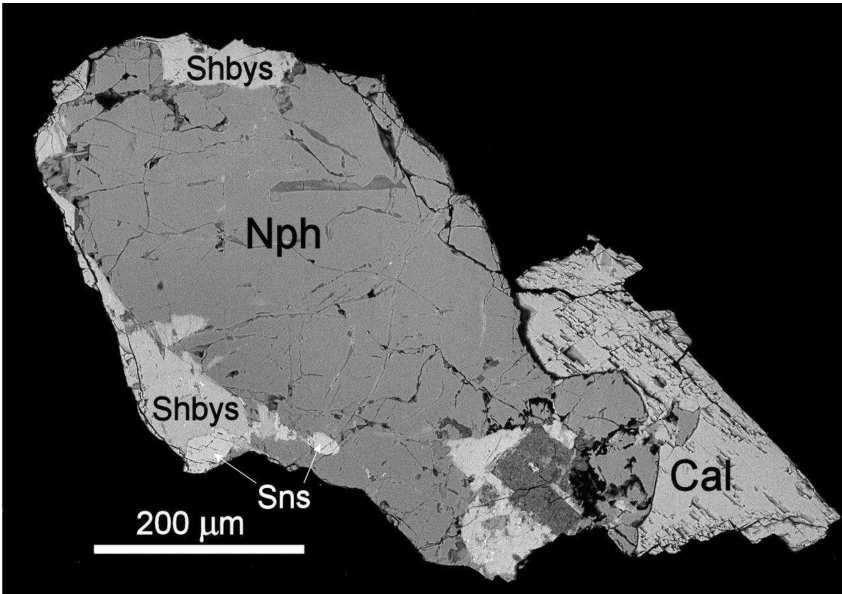
Figure 4. Mineral association of sulfhydrylbystrite (Shbys, Sample 11) with calcite (Cal), nepheline (Nph) and stronalsite (Sns). SEM (BSE) image of a polished section. Samples 13a and 13b are two varieties of the SO 32 − -bearing analogue of marinellite- forming pale violet and deep violet grains, respectively, up to 1 mm across in a subvolcanic rock mainly composed of sanidine with subordinate biotite and minor nepheline and leucite (Figure 5). The specimens originate from Magliano, Rome, Latium, Italy. The chemical com- position of Sample 13b based on six spot analyses is (wt.%, all sulfur was calculated as SO 3 ): Na 2 O 14.01, K 2 O 8.44, CaO 5.52, Al 2 O 3 27.90, SiO 2 32.79, SO 3 9.72, Cl 1.09, H 2 O (determined by the Alimarin method) 0.95, –O=Cl –0.26, total 100.18, which corresponds to the empirical formula (Na 29.78 K 11.81 Ca 6.49 )(Si 35.05 Al 36.05 O 24 )(SO 4 ,SO 3 ) 8.00 Cl 2.03 (OH) 0.49 · 3.25H 2 O ( Z = 1). The crystal structure of Sample 13b was refined to an R -factor of 5.71% for 6819 independent reflections with I > 2 σ ( I ) [66]. The mineral is trigonal, in space group P 31 c and the unit cell parameters are: a = 12.8727(2), c = 31.7393(5) Å and V = 4554.75(15) Å 3 . The crystal chemical formula is Na 29.78 K 11.82 Ca 6.40 (Si 36 Al 36 O 144 )(SO 4 ) 6 (SO 3 ) 2 Cl 2 (OH) 0.40 · 3.98H 2 O. The SO 32 − groups dominate at an extra-framework site hosted by the liottite cage.